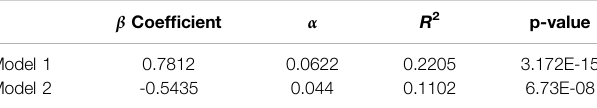
TABLE 3 | Regressions Analysis and